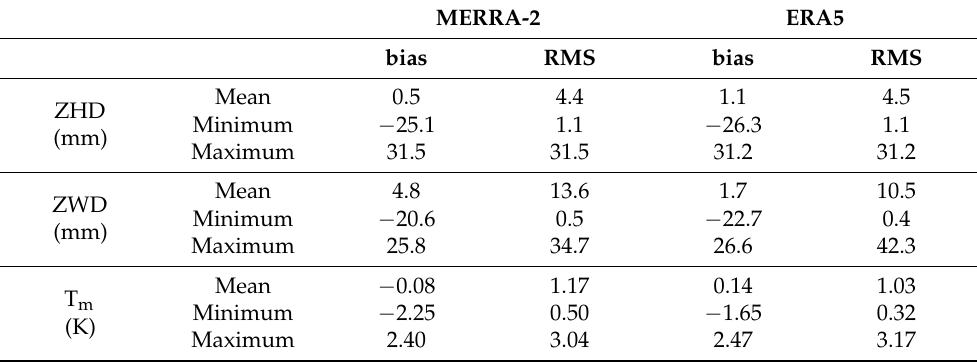
Table 4. Statistical results of ZHD, ZWD, and T m derived from MERRA-2 and ERA5 pressure-level data tested by radiosonde